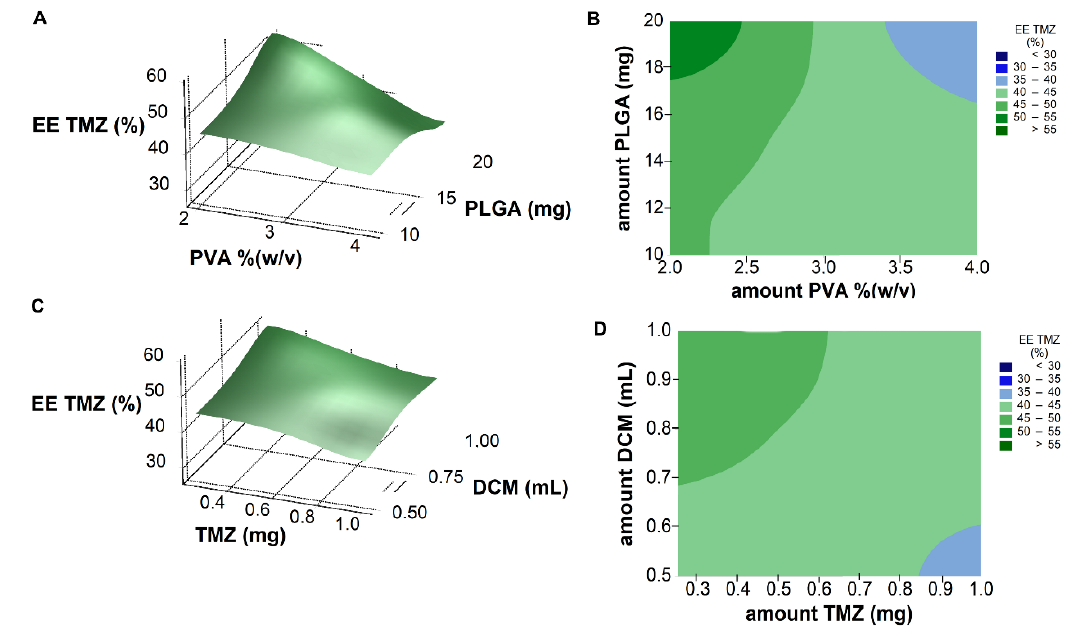
Figure 4. ( A ) Response surface plot and ( B ) contour plot showing the e ff ect of two factors (amount of PVA and PLGA, respectively) on the resulting EE TMZ values. ( C ) Response surface plot and ( D ) contour plot showing the e ff ect of two factors (amount of TMZ and DCM, respectively) on the resulting EE TMZ values.